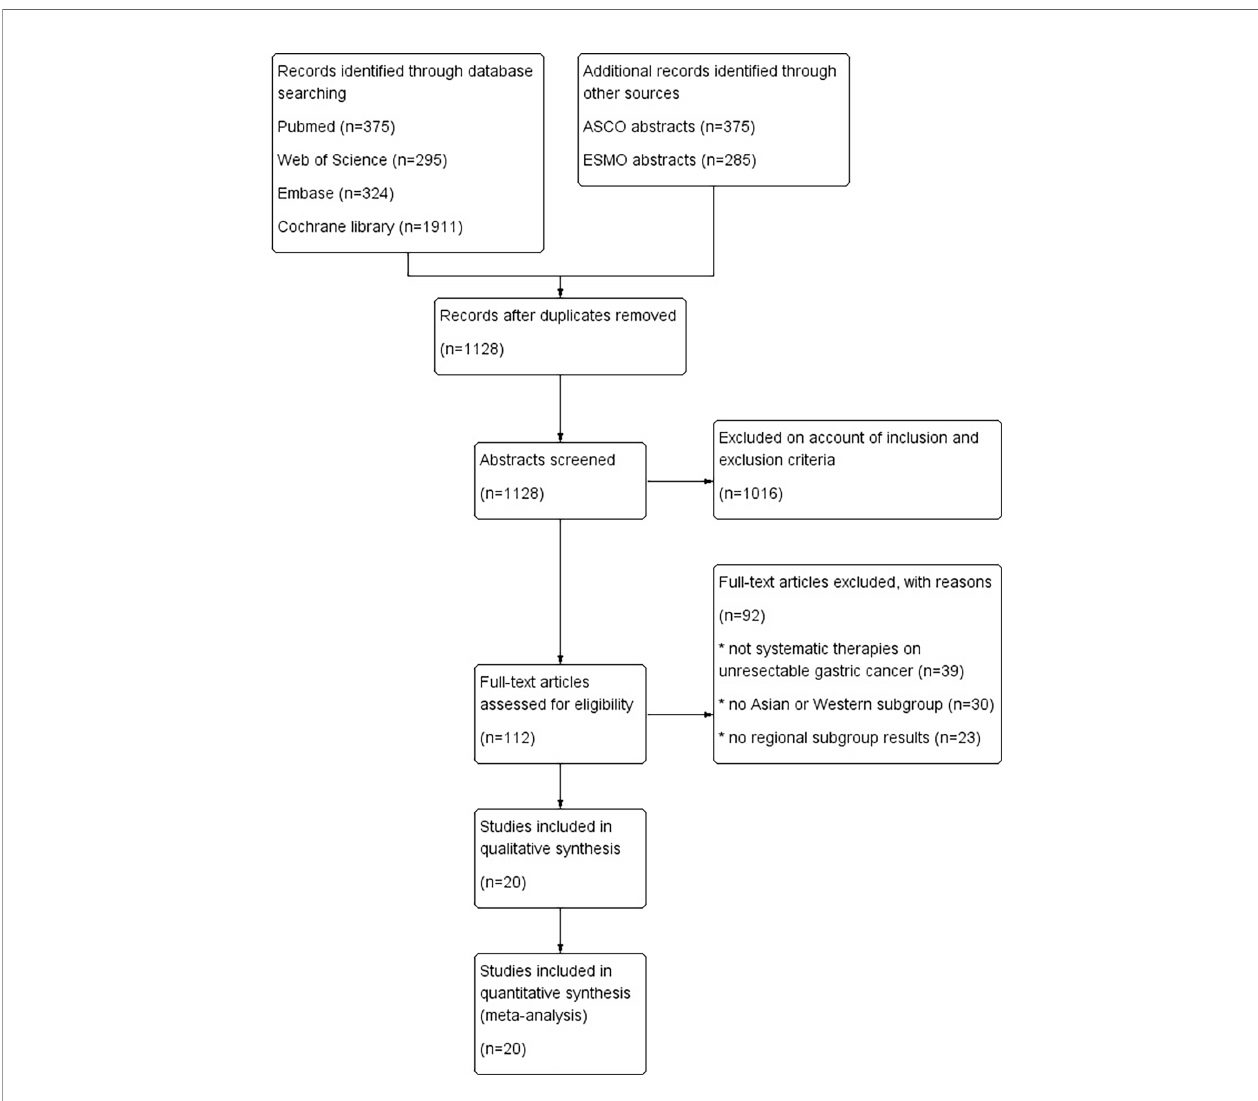
FIGURE 1 | PRISMA fl ow diagram for the